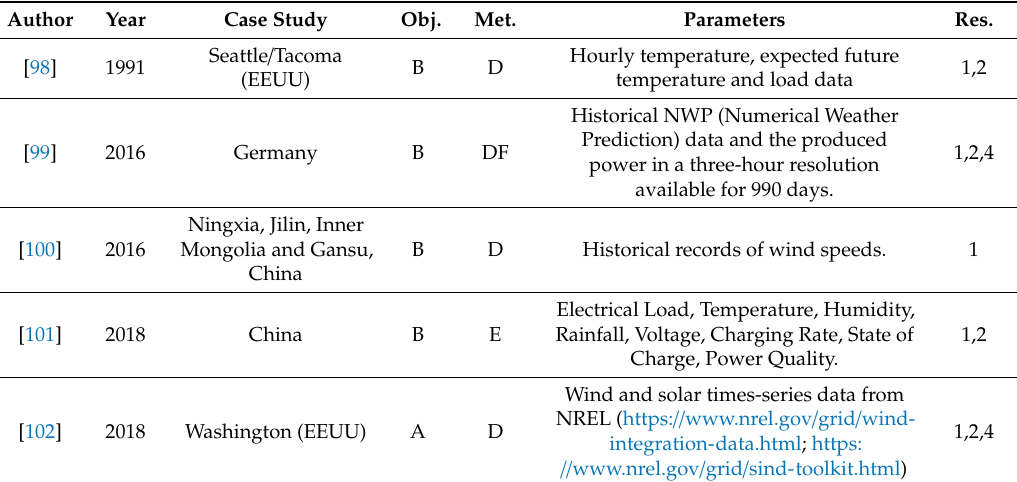
Table 6. References about recent research